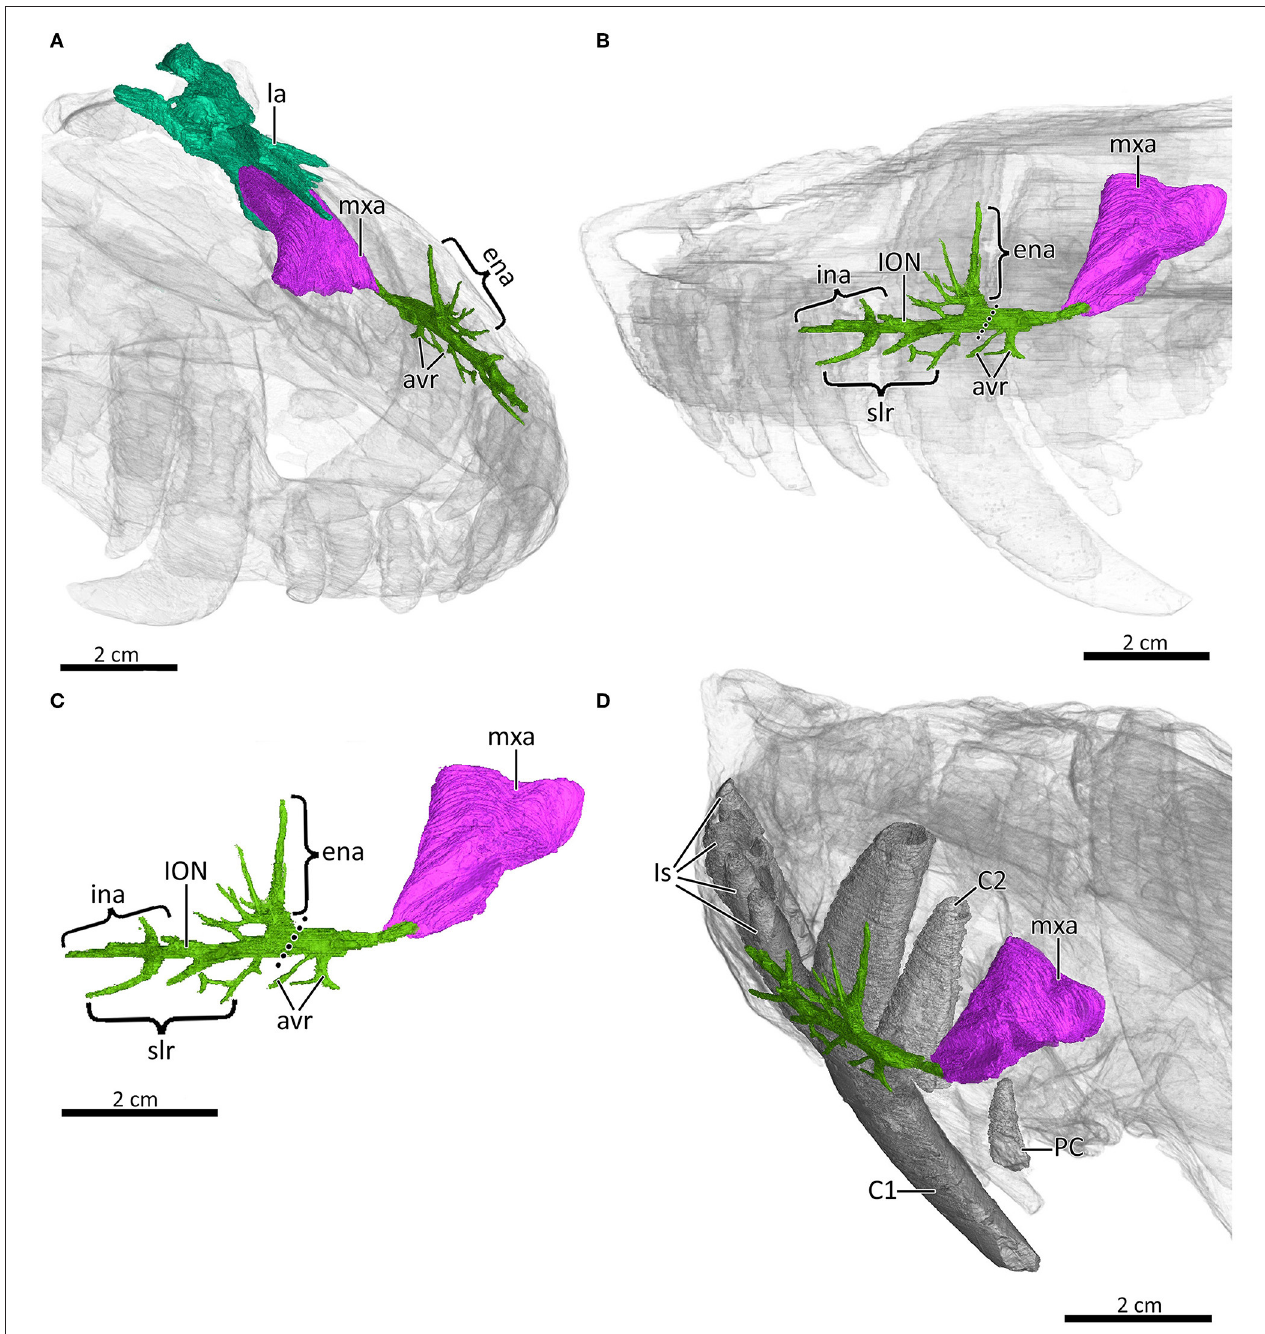
FIGURE 6 | 3D reconstructions of the maxillary canal (in green), maxillary antrum (in pink), and the lacrimal (in turquoise) of MB.R.995 in (A) right anterodorsolateral view with the snout transparent, (B) left lateral view with the snout transparent, (C) left lateral view, and (D) right posterodorsolateral view with the snout transparent. Dotted line illustrates the caudal extremity of the infraorbital nerve. avr, alveolar rami of the CNV 2 ; C1, first canine; C2, second canine; ena, external nasal rami of the ION; ina; internal nasal rami of the ION; ION, infraorbital nerve; Is, upper incisors; la, lacrimal; mxa, maxillary antrum; PC, upper postcanine; slr, superior labial rami of the